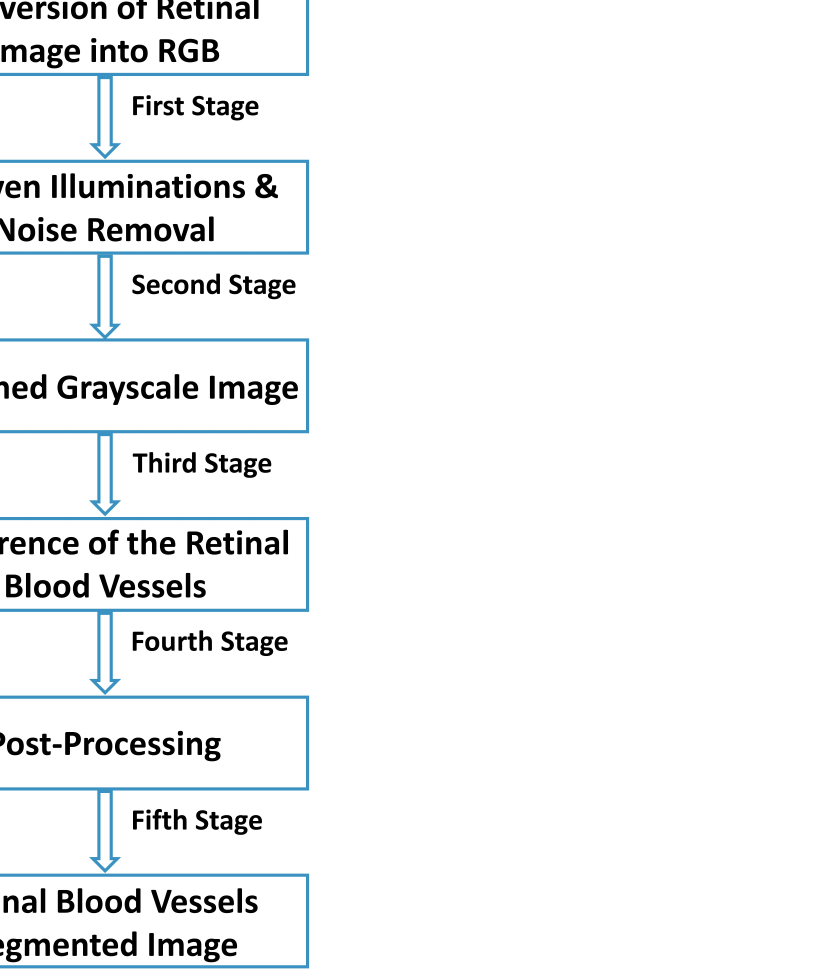
Figure 1. Proposed methods for the impact of image coherence schemes for segmentation of retinal blood